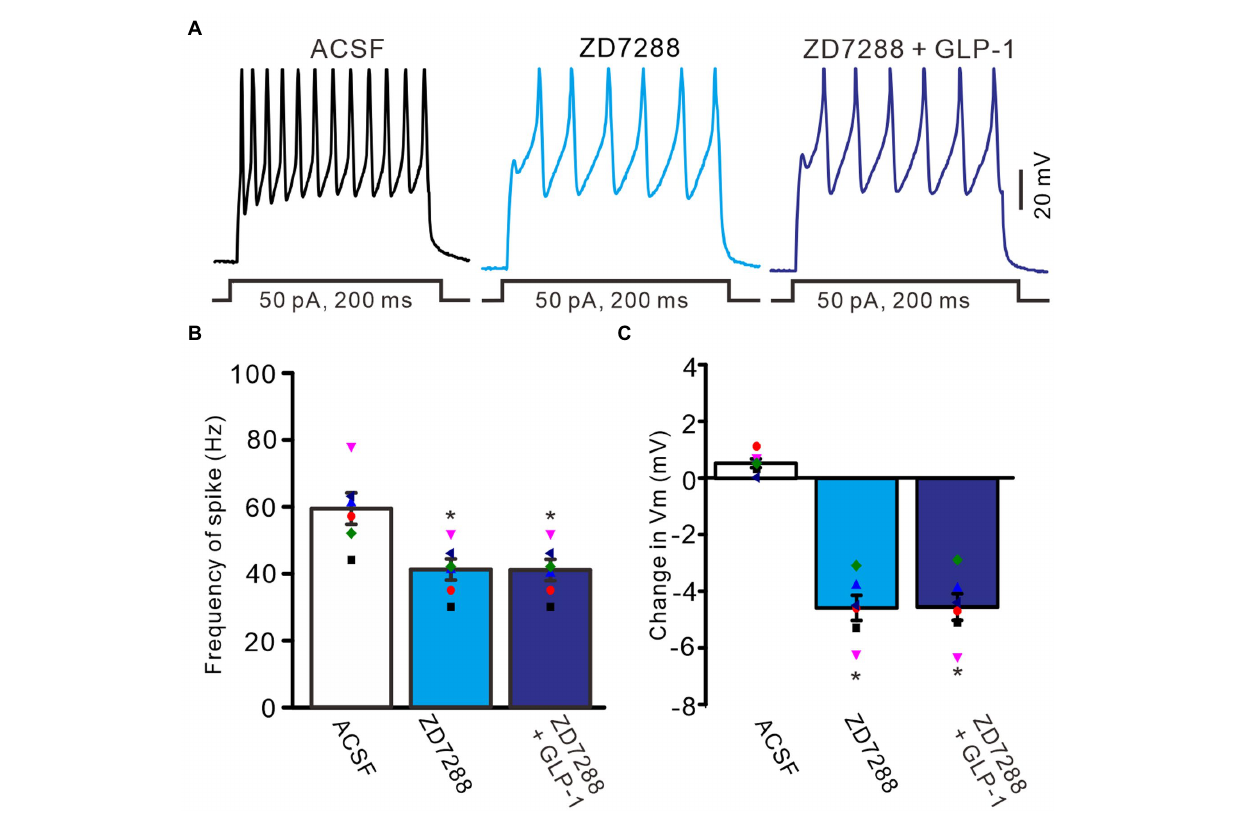
FIGURE 7 Blockade of IH, GLP-1 failed to enhance the excitability of PCs. (A) Under current-clamp recording mode (Vm = − 80 mV), the representative traces showing PCs in response to depolarization currents (50 pA, 200 ms) during treatments of ACSF, ZD7288 (50 μ M), and ZD7288 (50 μ M) + GLP-1 (100 nM). (B) The mean (± S.E.M) with individual data showing the number of spikes evoked by depolarization current during each treatment. (C) The mean (± S.E.M) with individual data showing the change of resting membrane potential during each treatment. * p < 0.05 vs. ACSF, n = 6 cells in each